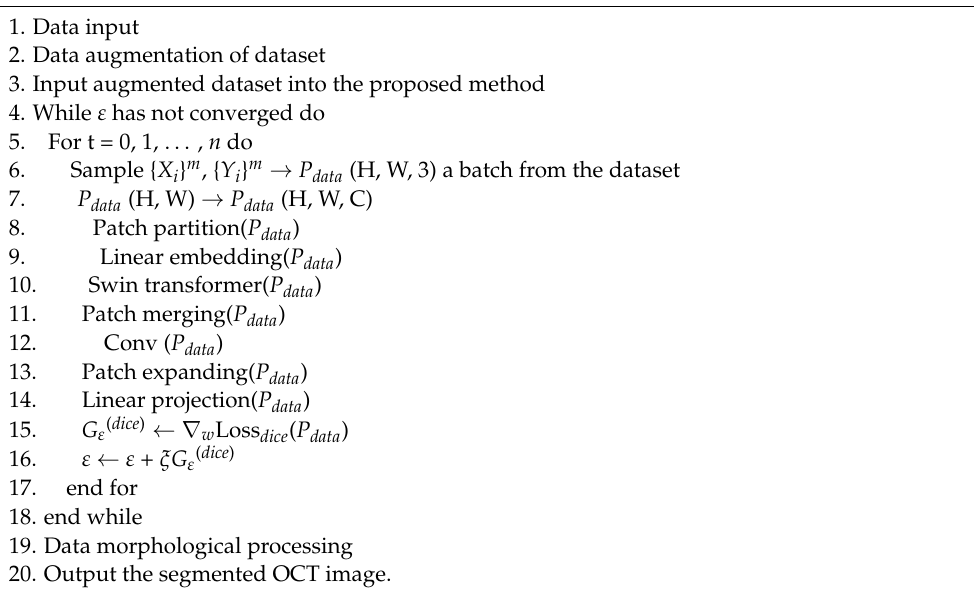
Algorithm 1 The Proposed